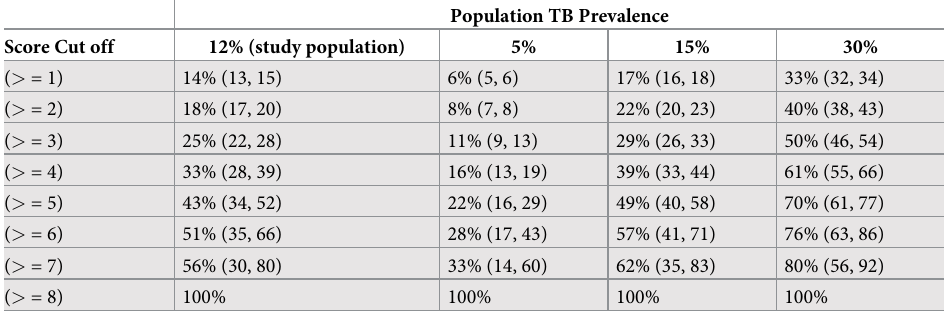
Table 4. Positive predictive value (PPV), with 95% CI, of symptom count plus two additional points for under- weight status, at multiple cutoff values and multiple prevalences of TB.